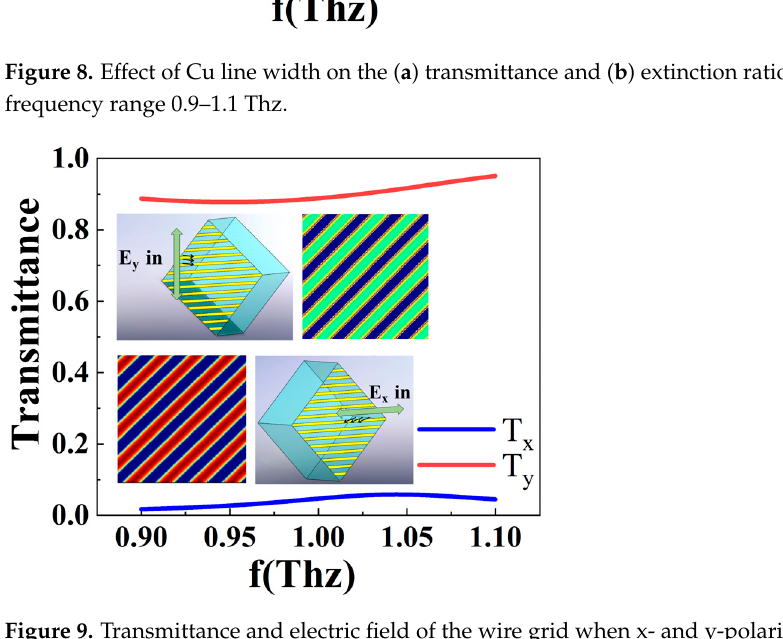
Figure 9. Transmittance and electric field of the wire grid when x- and y-polarized light is incident.